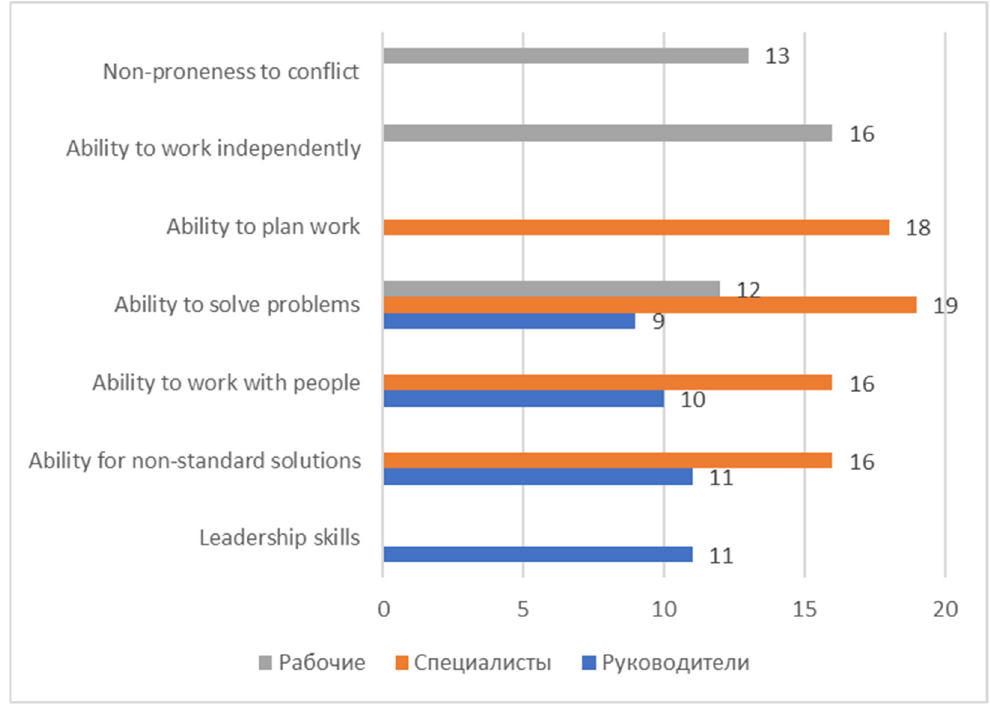
Figure 4. Skills that Russian employees lack. Source: the authors based on data from Nghia (2019). According to Nghia (2019), 13% of the surveyed employers stated that workers lack the skill to not be prone to conflict. Additionally, 16% of the surveyed employers noted that workers lack such skills as the ability to work independently. In addition, 12% of the